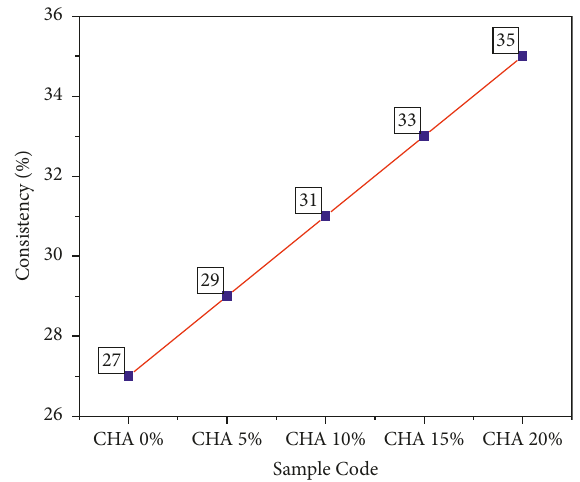
Figure 4: Normal consistency of blended pastes containing